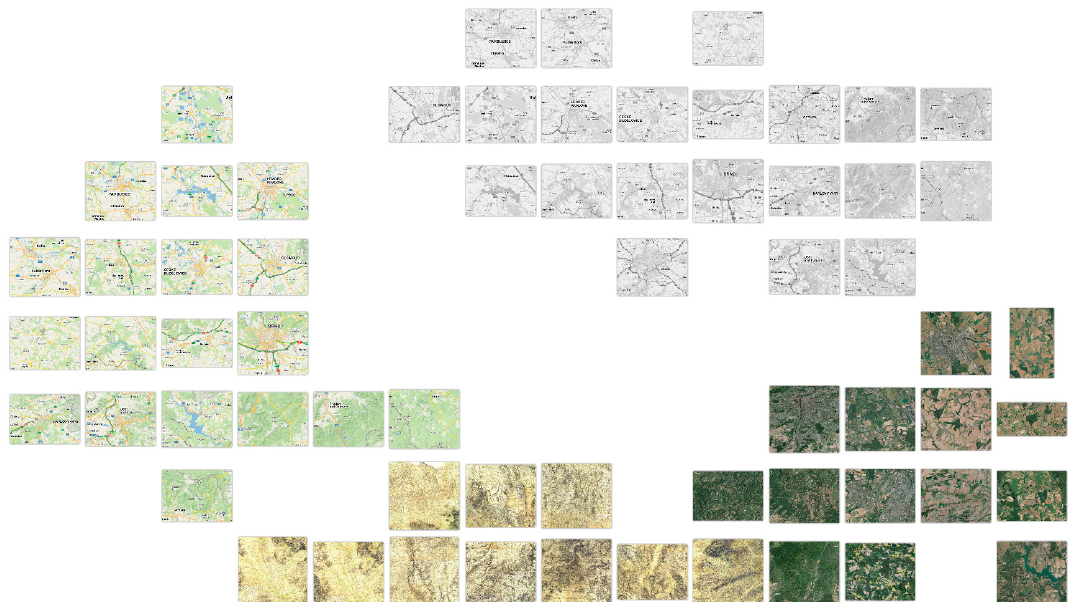
Figure 6. Image grid in Orange with the thumbnail of the tested map, with four evident clusters arranged according to base maps, historical, aerial, and black and white (author’s work).